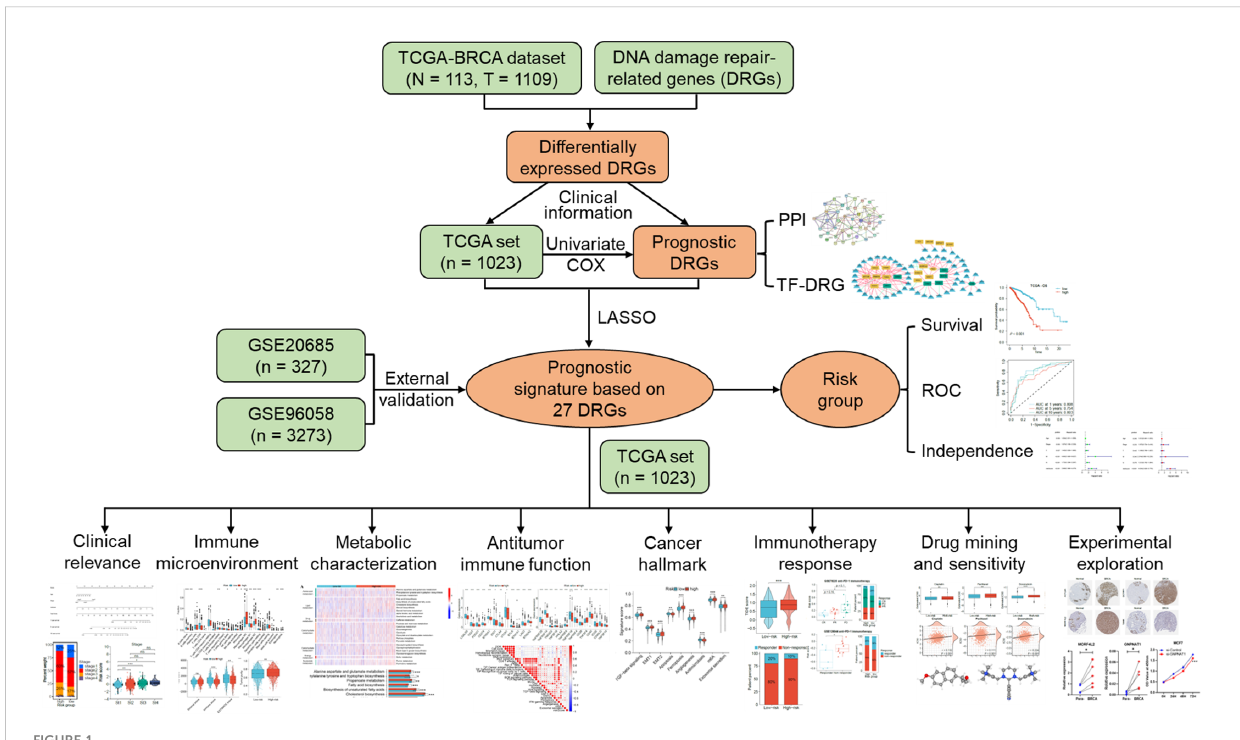
FIGURE 1 The overall framework of this